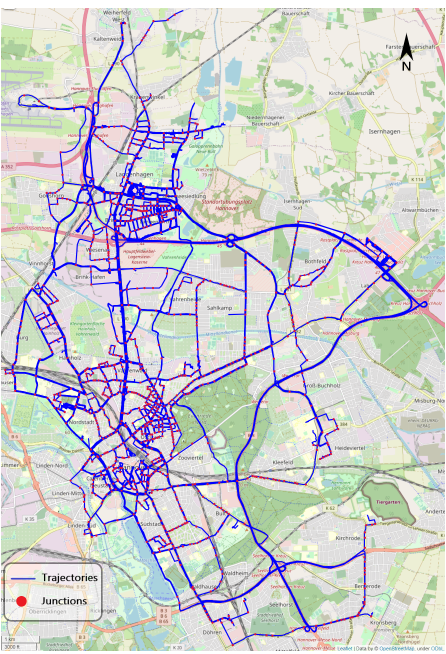
Figure 2. Hannover Dataset. Vehicles trajectories are the blue lines and red points symbolize